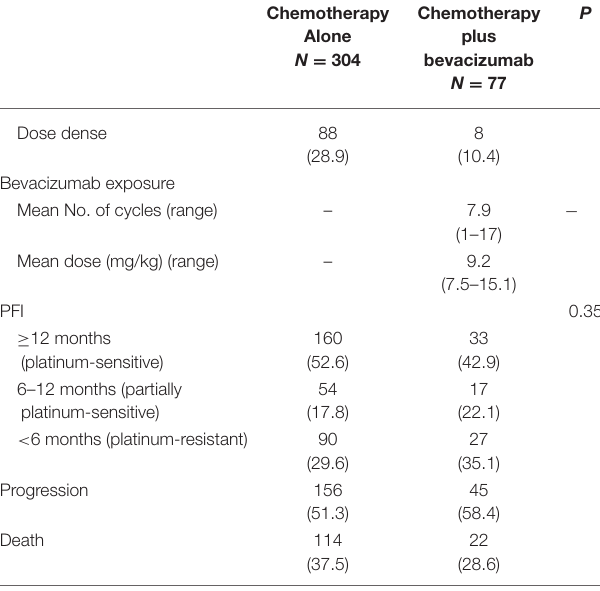
SD, standard deviation; PFI, progression-free interval.